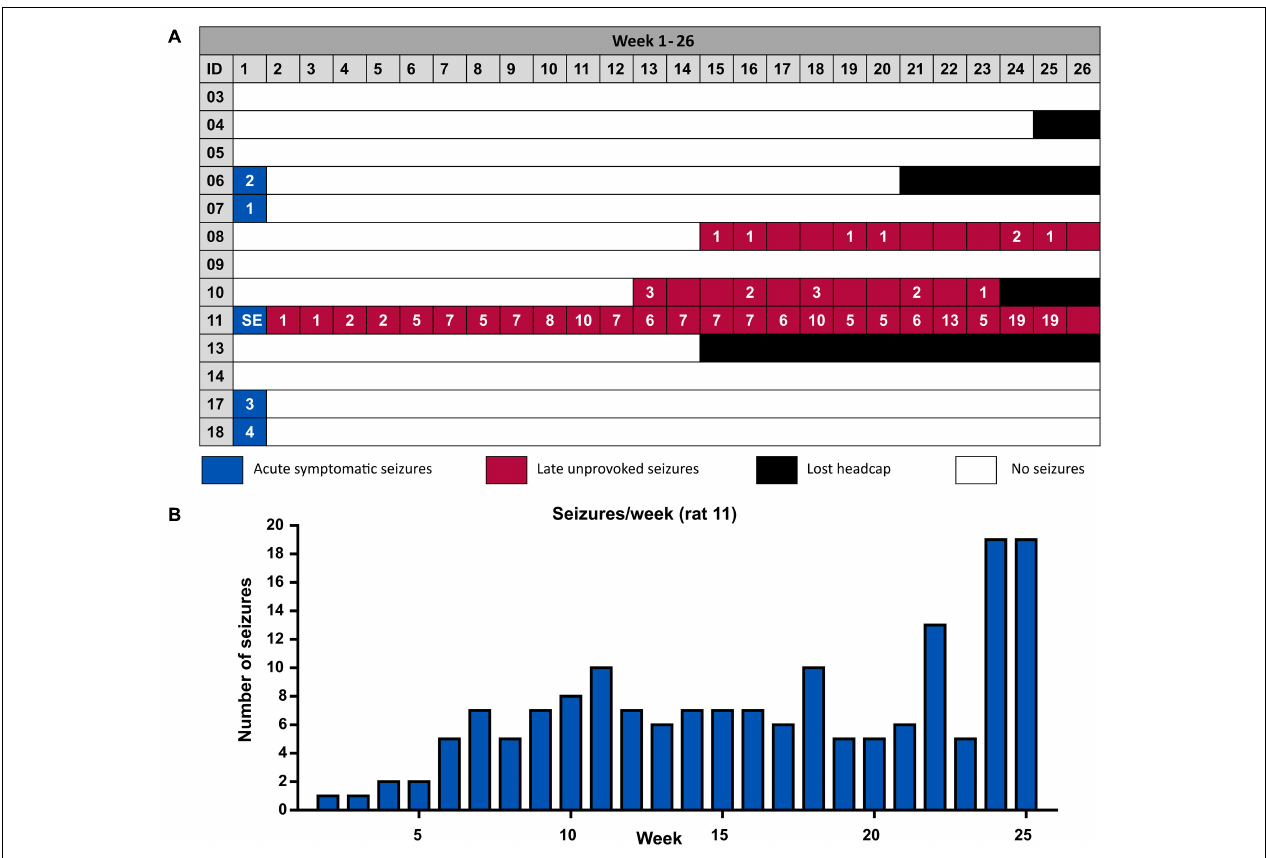
FIGURE 3 | (A) Overview of the occurrence of acute symptomatic seizures and late unprovoked seizures per animal. Four animals did not complete the complete monitoring period due to the loss of their head cap with EEG electrodes. The last week of the experiment (week 26) consists of 5 days instead of 7, since monitoring was stopped at 180 days. (B) Number of seizures per week of the SE